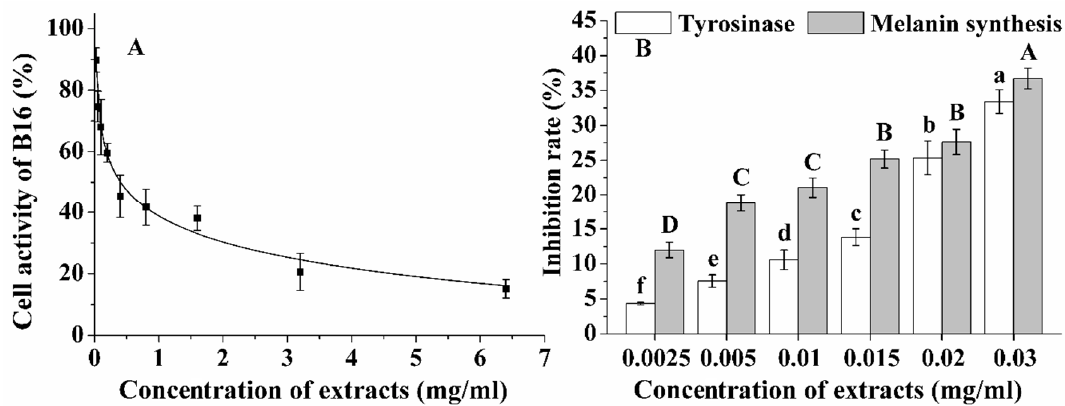
Figure 6. The cell activity ( A ) and the inhibition rate of tyrosinase and melanin synthesis ( B ) in B16 cells. Capital letters indicate differences in the inhibition rate of melanin synthesis under different treatment; lowercase letters indicate differences in the inhibition rate of tyrosinase under different treatment ( p < 0.05).